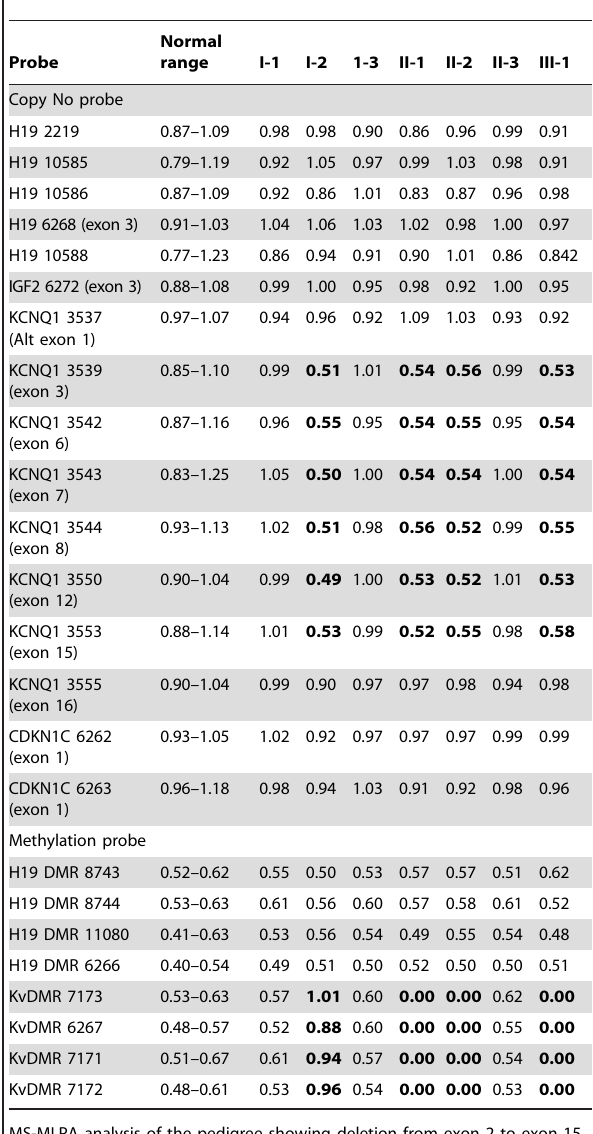
Table 2. Methylation sensitive